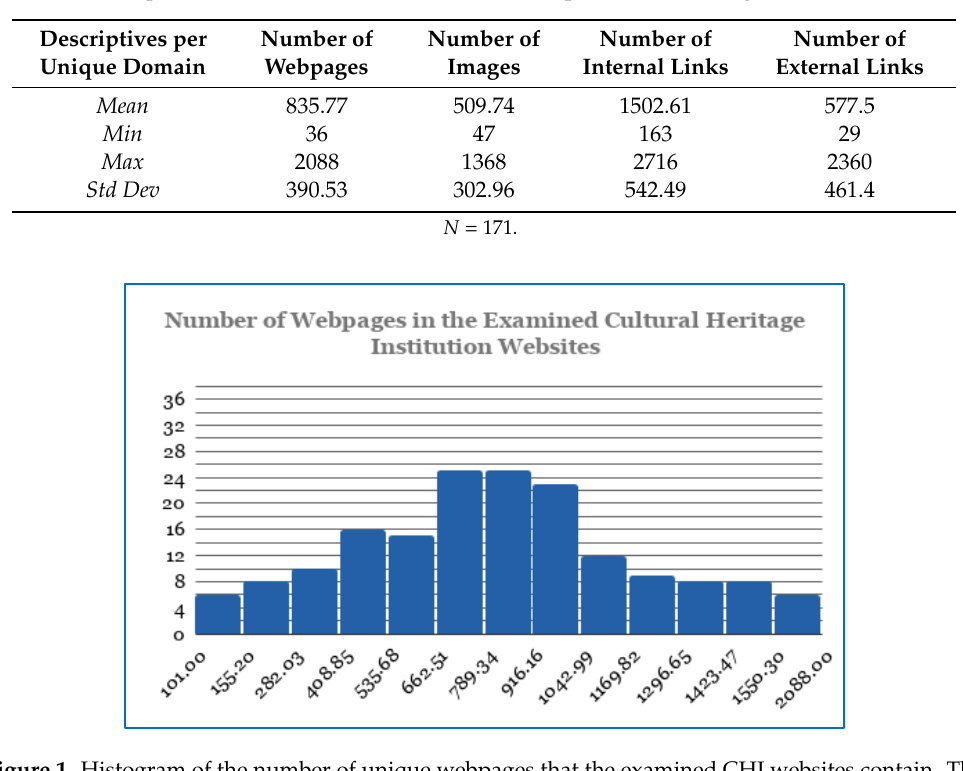
Table 1. Descriptive statistics from the examined 171 unique cultural heritage institution websites.